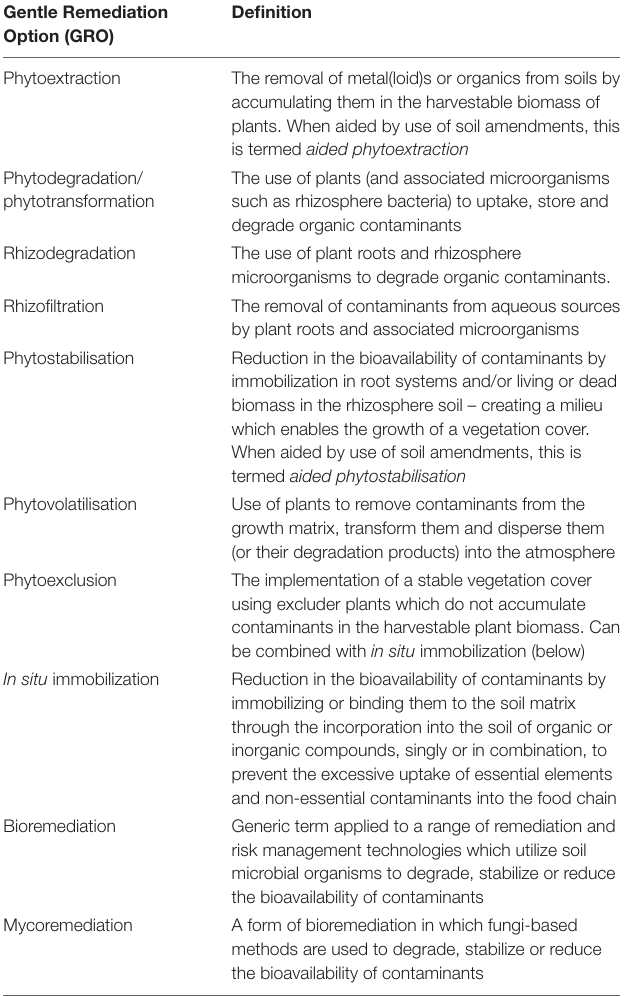
TABLE 1 | Examples of gentle remediation